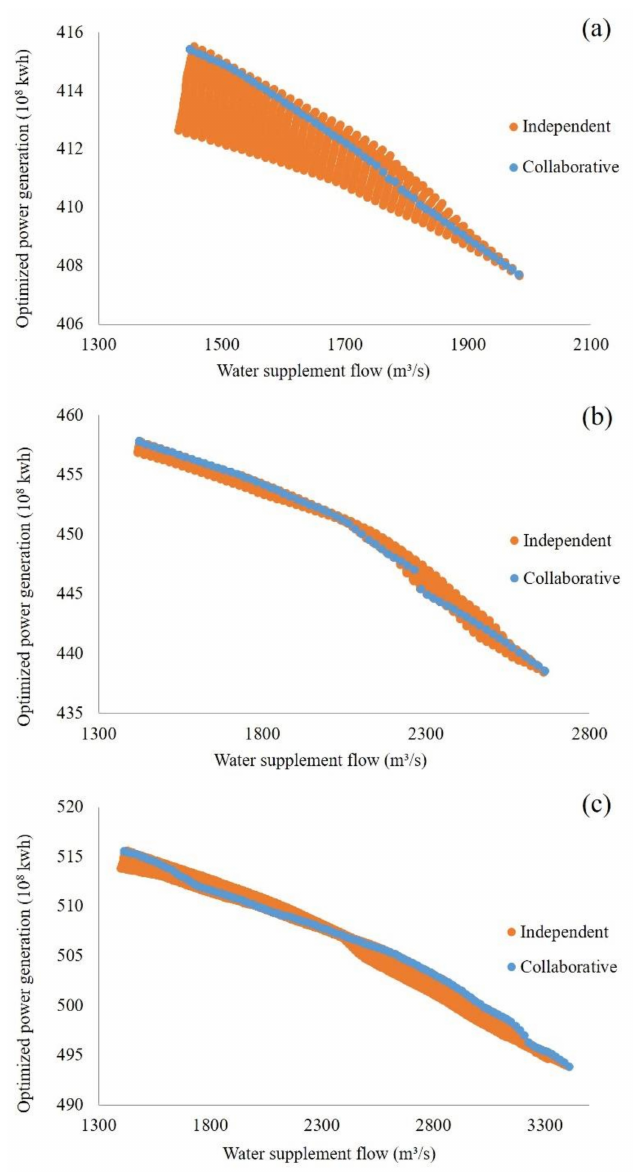
Figure 10. Optimization results of “flow-energy” relationship under “collaborative-independent” joint optimization. ( a ) April 1997, ( b ) March 1999, and ( c ) March